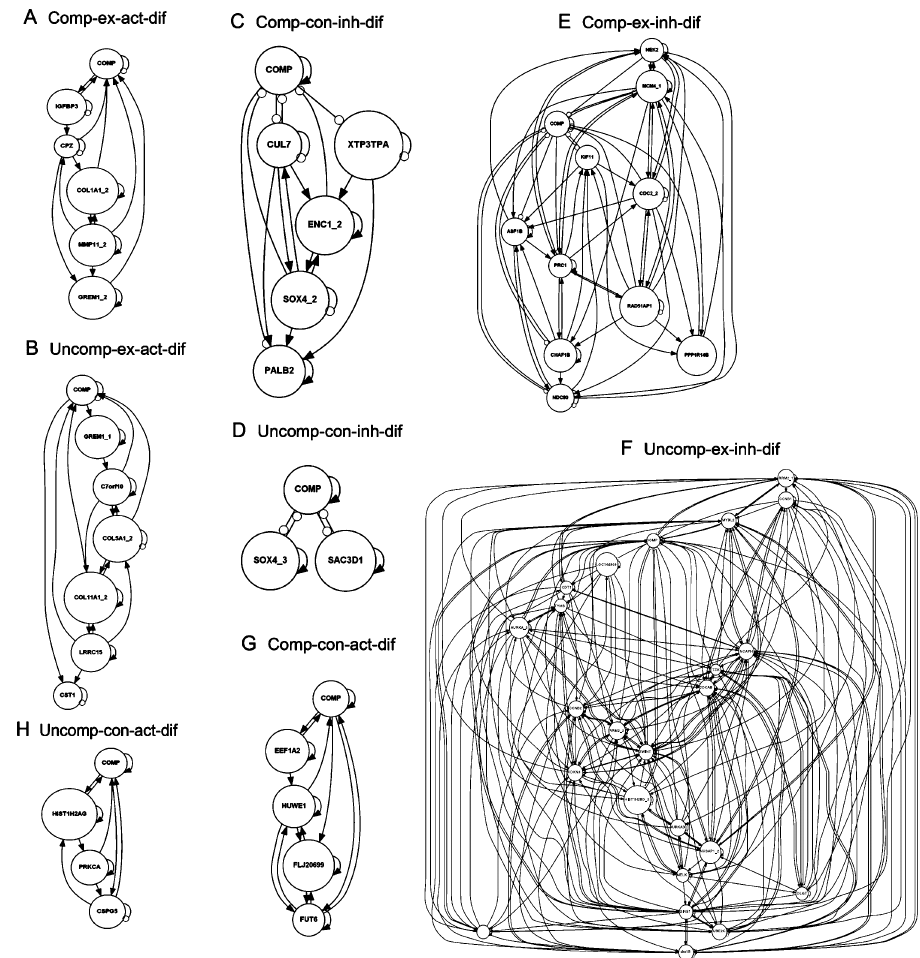
Fig. 3. The novel different COMP -activated and -inhibited directionality networks by GRNInfer and our programming. (A) Complete (all no positive correlation, Pearson CC<0.25) and (B) uncomplete (partly no positive correlation except COMP , Pearson CC<0.25) different COMP -activated network in higher lung adenocarcinoma compared with lower expression of human normal adjacent tissues by GRNInfer and our programming, respectively. n =25. (C) Complete and (D) uncomplete different COMP -inhibited network in lower human normal adjacent tissues compared with higher lung adenocarcinoma by GRNInfer and our programming, respectively. n =25. (E) Complete and (F) uncomplete different COMP -inhibited network in higher lung adenocarcinoma compared with lower expression of human normal adjacent tissues by GRNInfer and our programming, respectively. n =25. (G) Complete and (H) uncomplete different COMP -activated network in lower expression of human normal adjacent tissues compared with higher lung adenocarcinoma by GRNInfer and our programming, respectively. n =25. Black arrow represents as activated relationship and empty circle as inhibited relationship. Comp, complete; Uncomp, uncomplete; con, human normal adjacent tissues; ex, lung adenocarcinoma; act, activation; inh, inhibition; dif,